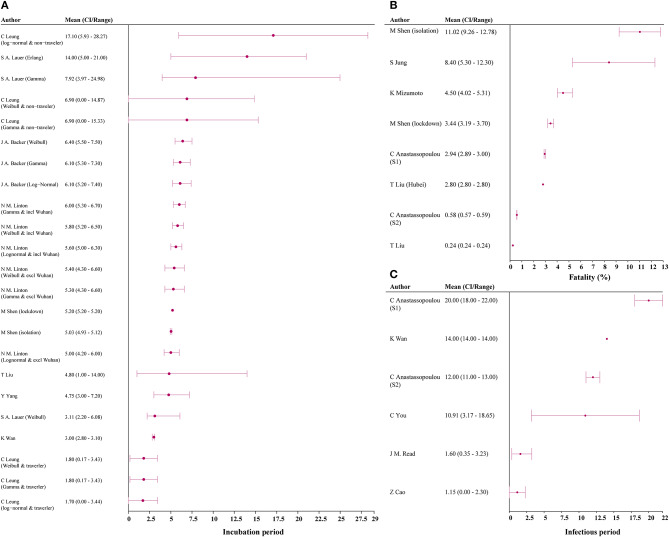
Incubation, case-fatality rate, and infectious period estimates among models. (A) incubation period; (B) fatality; (C) infectious period. CI, confidence interval; S1, scenario 1; S2, scenario 2.